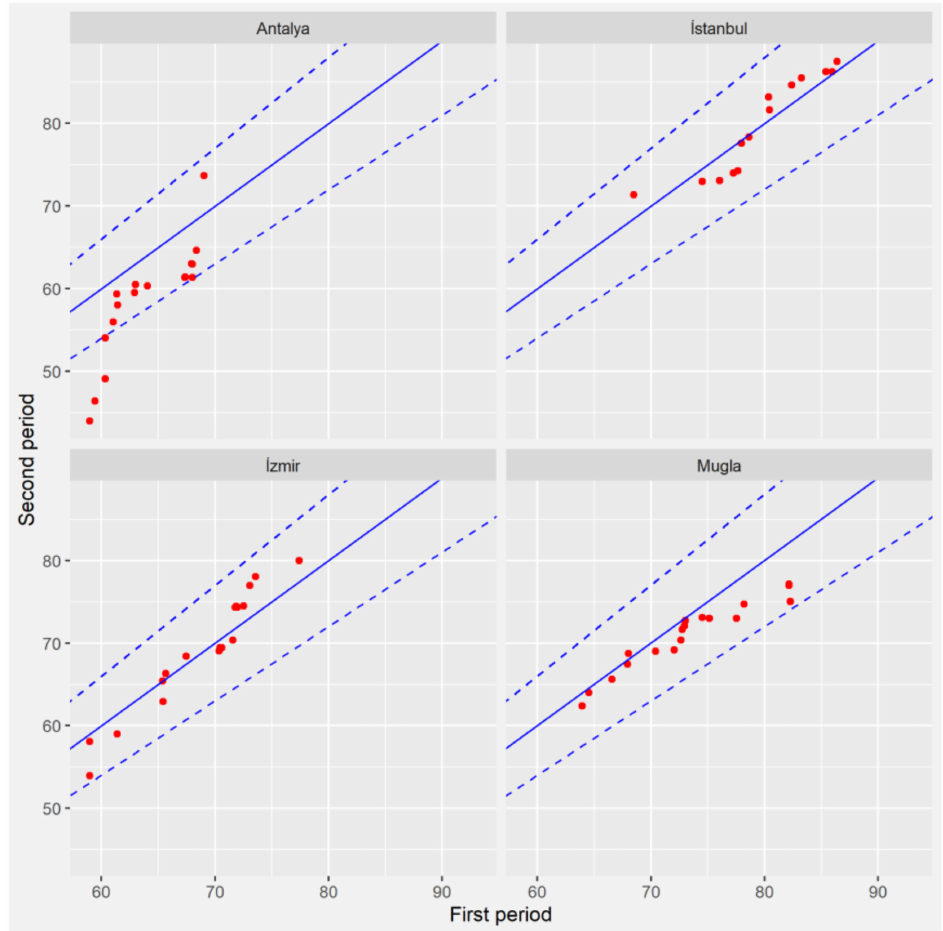
Figure 12. Sen trend analysis of TCI of